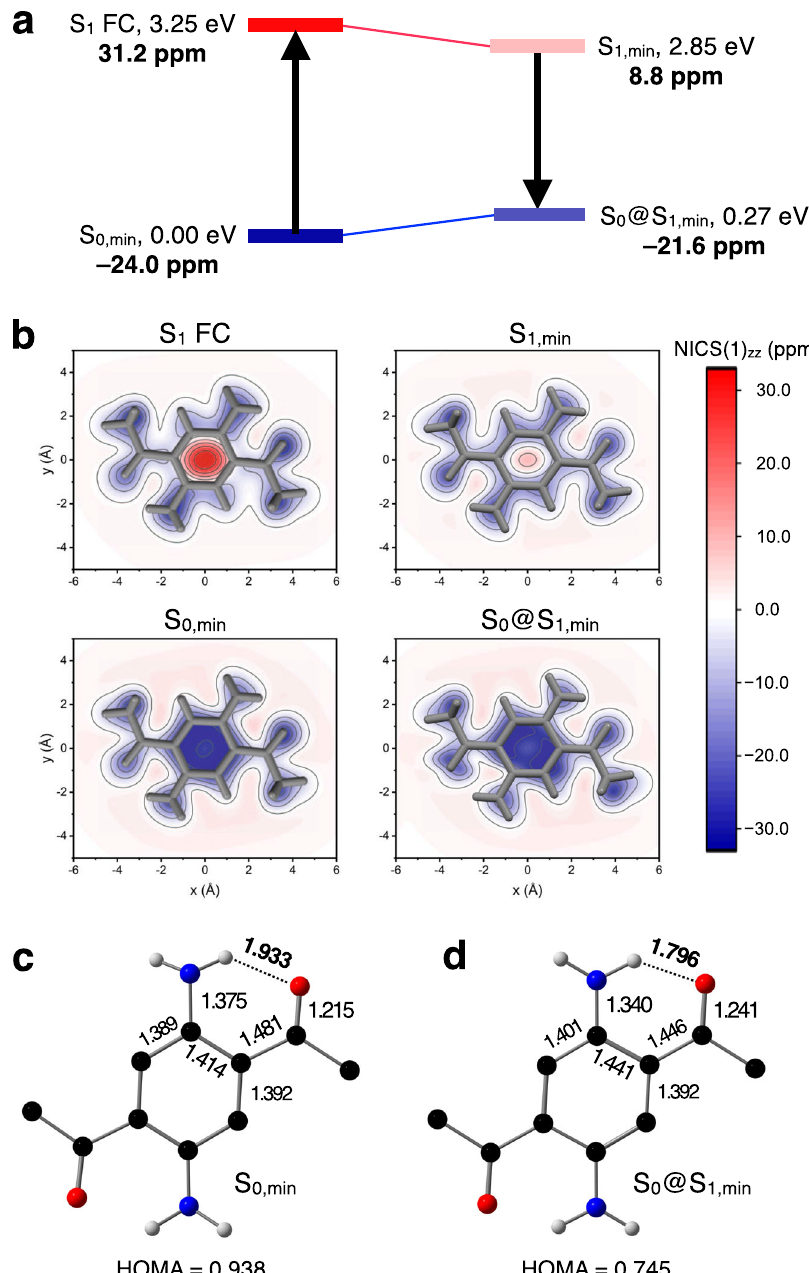
Fig. 6 Relief of excited-state antiaromaticity assisted by intramolecular hydrogen bonds. a Schematic energy diagram with calculated NICS(1) zz values (in bold) at the optimized geometries of p -DAPA. b Calculated NICS(1) zz grids parallel to the molecular plane of p -DAPA. c , d Bond lengths (Å) and HOMA value of p -DAPA at the S 0,min ( c ), and S 0 @S 1,min ( d ) geometry. FC Franck – Condon, min minimum, NICS nucleus-independent chemical shift, HOMA harmonic oscillator model of